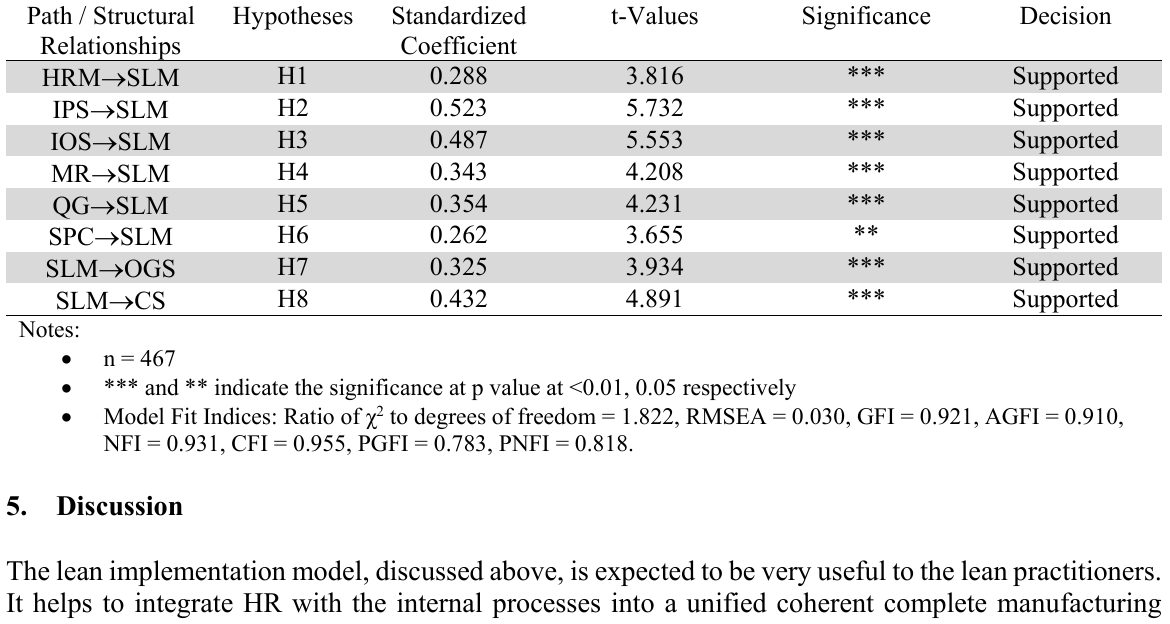
Results of Structural Equation Modelling Path /